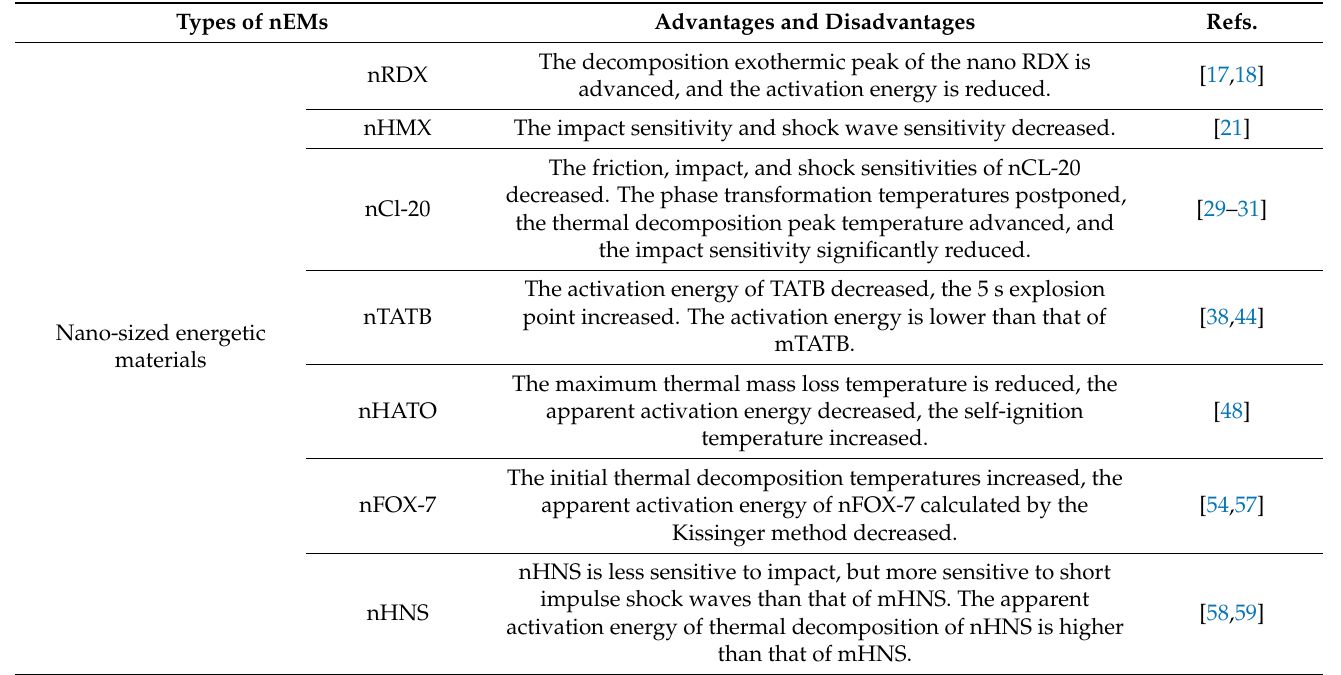
Table 3. Summary of advantages and disadvantages of nEMs on the performance of propellants and